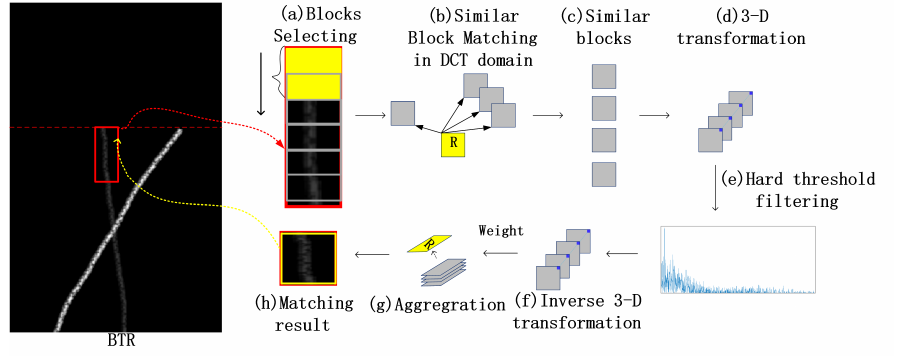
Figure 2. Frame of hard threshold